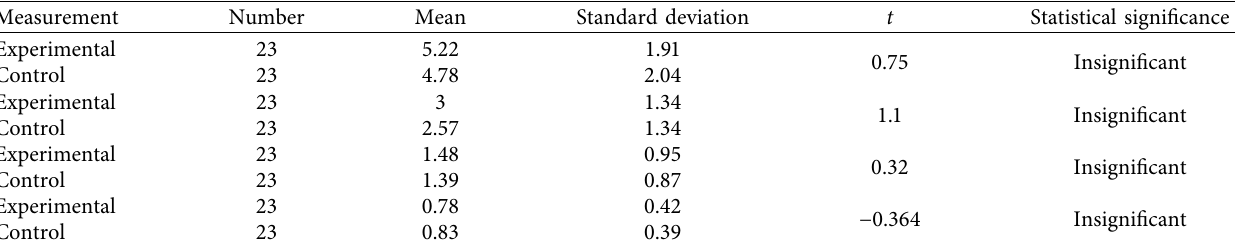
Table 2: t -test and the significance of the differences for the premeasurement of the two groups, experimental and control, in the reading comprehension skills